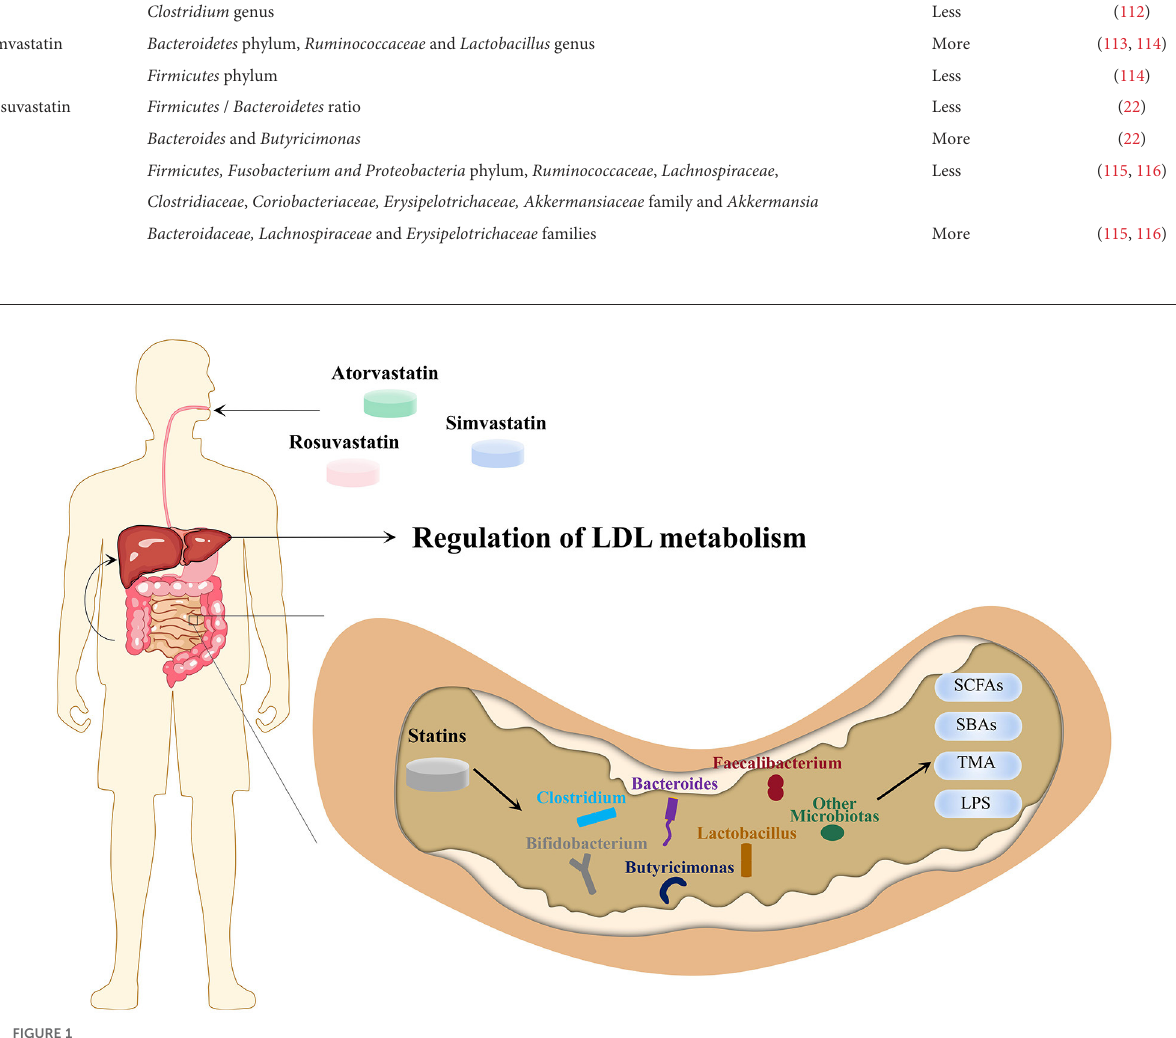
FIGURE1 Microbiota-driven, LDL-lowering effect of statins. Atorvastatin, simvastatin and rosuvastatin enter the intestine via the upper gastrointestinal tract through oral administration and affect the absolute and relative abundance of gut microbiota, which in turn affects SCFAs, SBAs, TMA, LPS and other MDMs. The MDMs are transported to the liver through the portal venous system, ultimately achieving the purpose of regulating cholesterol metabolism and LDL-C levels. LPS, lipopolysaccharides; MDMs, microbiota-derived metabolites; LDL-C, low-density lipoprotein cholesterol; SBAs, secondary bile acid; SCFAs, short-chain fatty acid; TMA,